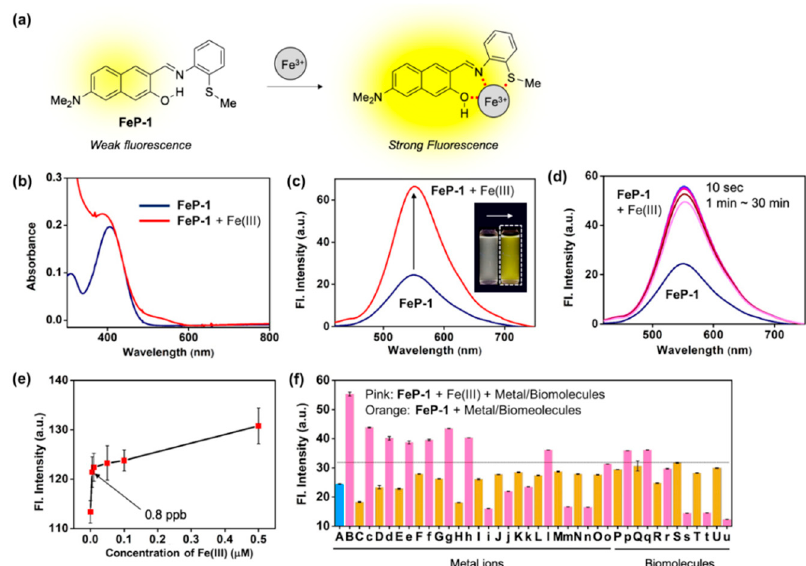
Figure 1. ( a ) Proposed sensing mechanism between Fe(III) and Schiff base fluorescence enhancement probe, FeP-1 . ( b , c ) Absorption and emission spectra of FeP-1 (10 µ M) after addition of Fe(III) (20 eq). Inset photo: color change of the probe under UV light (365 nm) after addition of the Fe(III) (20 eq). Each spectrum was acquired in ethanol-water solution (EtOH:DI H 2 O = 4:6, v / v ) after 1 min at 25 ◦ C under excitation at 397 nm. ( d ) Time-dependent fluorescence spectra of FeP-1 (10 µ M) with Fe(III) (20 eq). Emission spectrum was measured at 10 s, 1, 3, 5, 10, 20, 30 min after mixing together. ( e ) A plot of fluorescence intensity (peak height at 550 nm) of FeP-1 (0.5 µ M) after addition of Fe(III) (0–0.5 µ M). Mean and standard deviations was calculated in triplicate. ( f ) Fluorescence intensity plot (peak height at 550 nm) of FeP-1 (10 µ M) after addition of each metal ions (20 eq), amino acid (20 eq), and lysozyme (1–100 µ g / mL) in ethanol-water solution (EtOH:DI H 2 O = 4:6, v / v ), measured after 1 min at 25 ◦ C. (A) FeP-1 , (B) FeCl 3 , (C) FeCl 2 , (c) FeCl 2 + FeCl 3 , (D) Hg(NO 3 ) 2 , (d) Hg(NO 3 ) 2 + FeCl 3 , (E) AgCl, (e) AgCl + FeCl 3 , (F) CdCl 2 , (f) CdCl 2 + FeCl 3 , (G) NiCl 2 , (g) NiCl 2 + FeCl 3 , (H) CuCl 2 , (h) CuCl 2 + FeCl 3 , (I) PdCl 2 , (i) PdCl 2 + FeCl 3 , (J) ZnCl 2 , (j) ZnCl 2 + FeCl 3 , (K) (C 2 H 5 ) 3 PAuCl, (k) (C 2 H 5 ) 3 PAuCl + FeCl 3 , (L) KCl, (l) KCl + FeCl 3 , (M) CaCl 2 , (m) CaCl 2 + FeCl 3 , (N) NaCl, (n) NaCl + FeCl 3 , (O) MgCl 2 , (o) MgCl 2 + FeCl 3 , (P) L-Cysteine, (p) L-Cysteine + FeCl 3 , (Q) L-Glutamine, (q) L-Glutamine + FeCl 3 , (R) L-Lysine, (r) L-Lysine + FeCl 3 , (S) Lysozyme 1 µ g / mL, (s) Lysozyme 1 µ g / mL + FeCl 3 , (T) Lysozyme 10 µ g / mL, (t) Lysozyme 10 µ g / mL + FeCl 3 , (U) Lysozyme 100 µ g / mL, (u) Lysozyme 100 µ g / mL + FeCl 3 . Means and standard deviations calculated from multiple measurements (n = 5). Dotted-line: Fe(III)-responsive signal threshold (at 32 a.u.). The emission spectrum was measured under excitation at 397